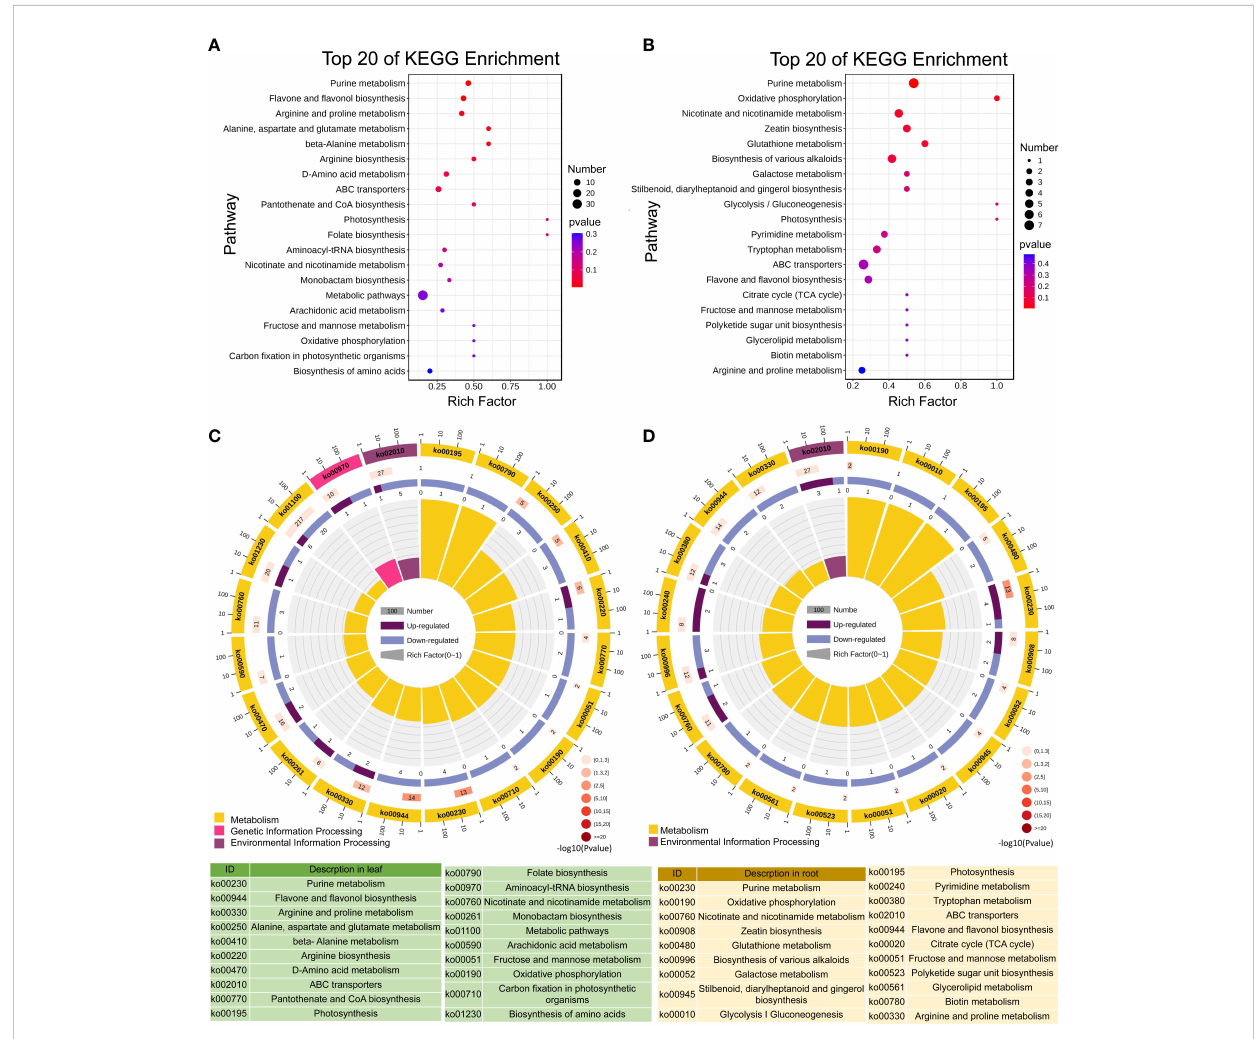
FIGURE 7 KEGG enrichment analysis of the differentially accumulated metabolites in the leaves and roots of tomato seedlings. Top 20 enriched KEGG pathways of DAMs between the control and Cd-treated leaves (A, C) ; top 20 enriched KEGG pathways of DAMs between the control and Cd-treated roots (B, D)